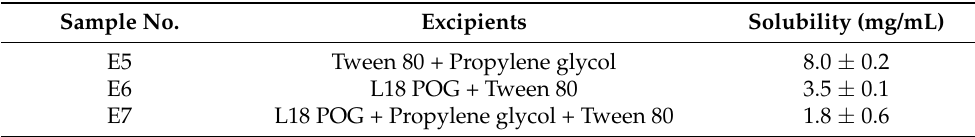
Table 2. Drug–excipient solubility study carried out at 70 ◦ C for 3 h. Data presented as mean ± SD (n = 3). Sample